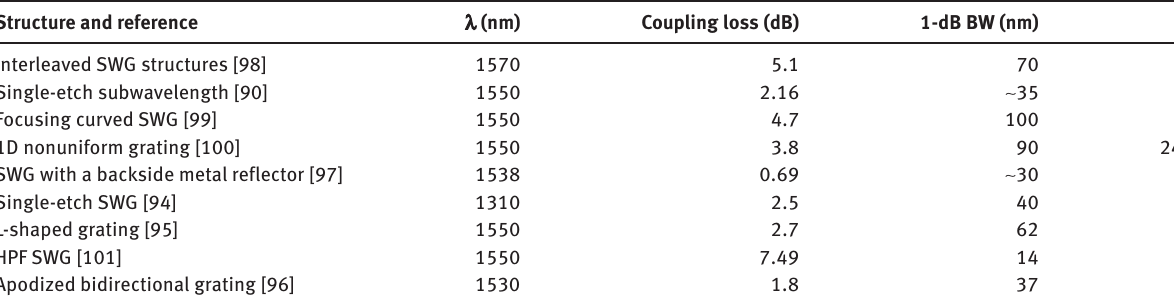
Table 6: Experimental results for subwavelength structured fiber-to-chip grating couplers. Structure and